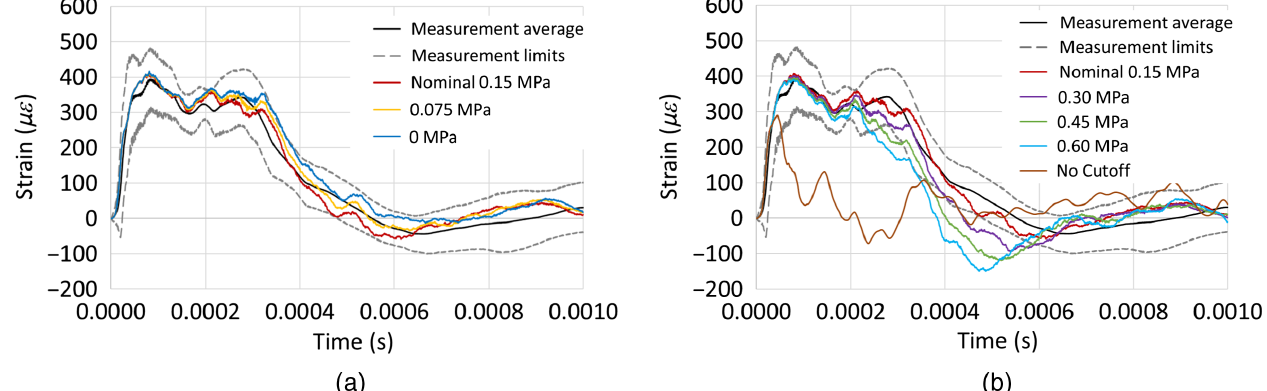
FIG. 20. Strain predictions of sensor Twith different mercury tensile cutoff pressures. (a) Decrease cutoff pressure. (b) Increase cutoff pressure.